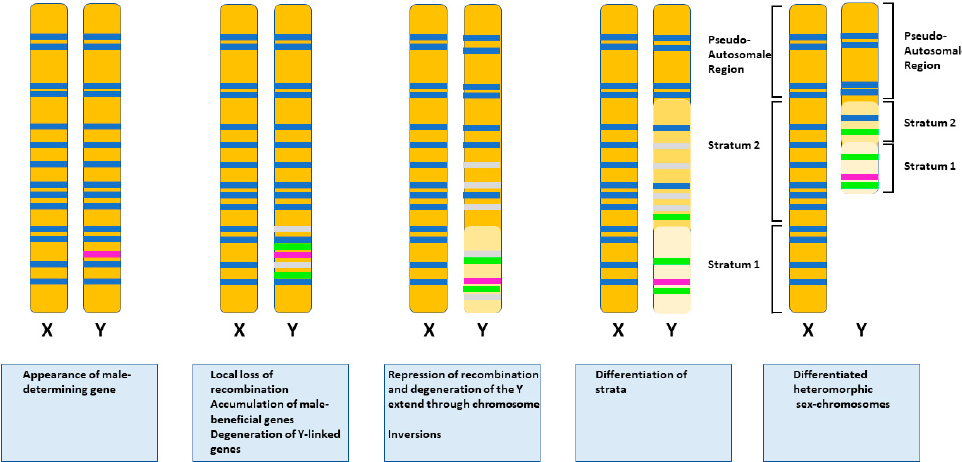
Figure 1. Current model for evolution of heteromorphic sex chromosomes from a pair of autosomes. Steps are shown from left to right. Ancestral genes are represented by dark blue lines, the male-determining gene is represented by a pink line, male beneficial genes are represented by green lines, and degenerating genes are represented by grey lines. Faded colours in the chromosome show the appearance of strata.